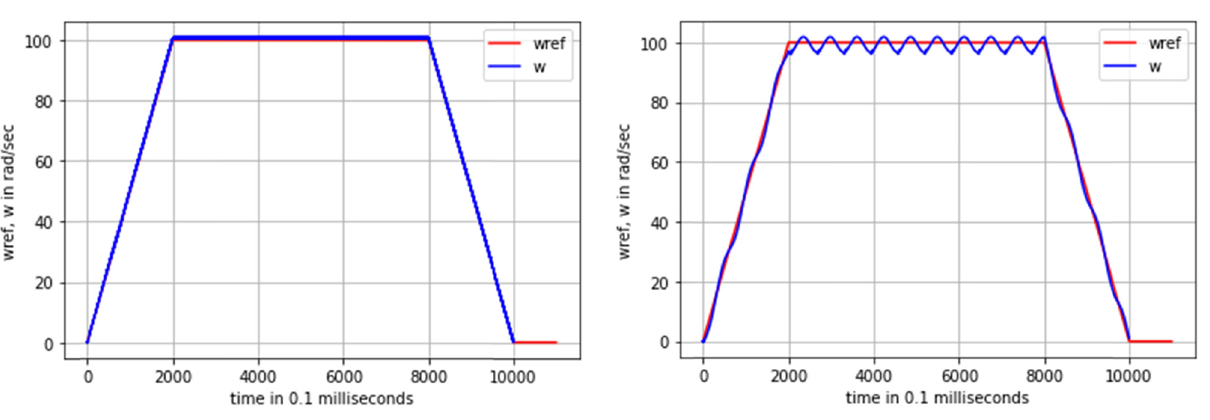
Figure 12: Response of PID control system for disturbance magni - tude of 3 × 10 − 1 .